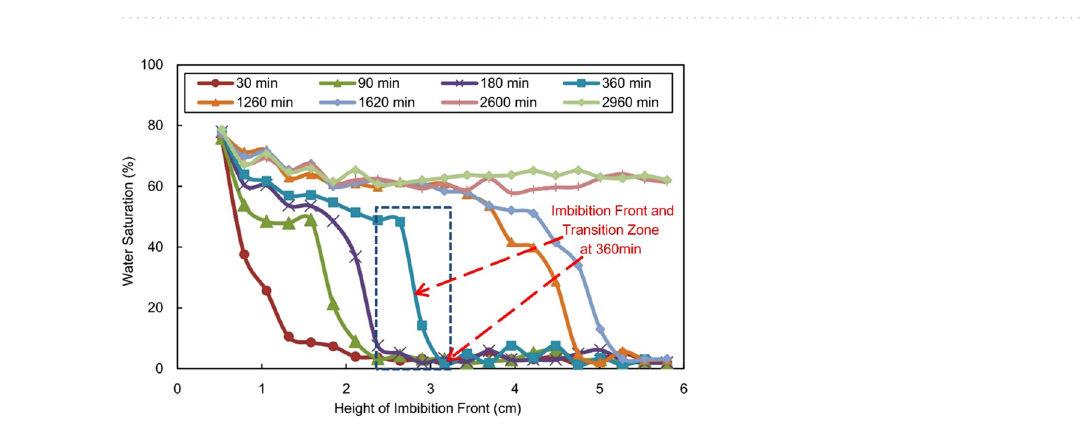
Figure 4. Images of water imbibition at different times.